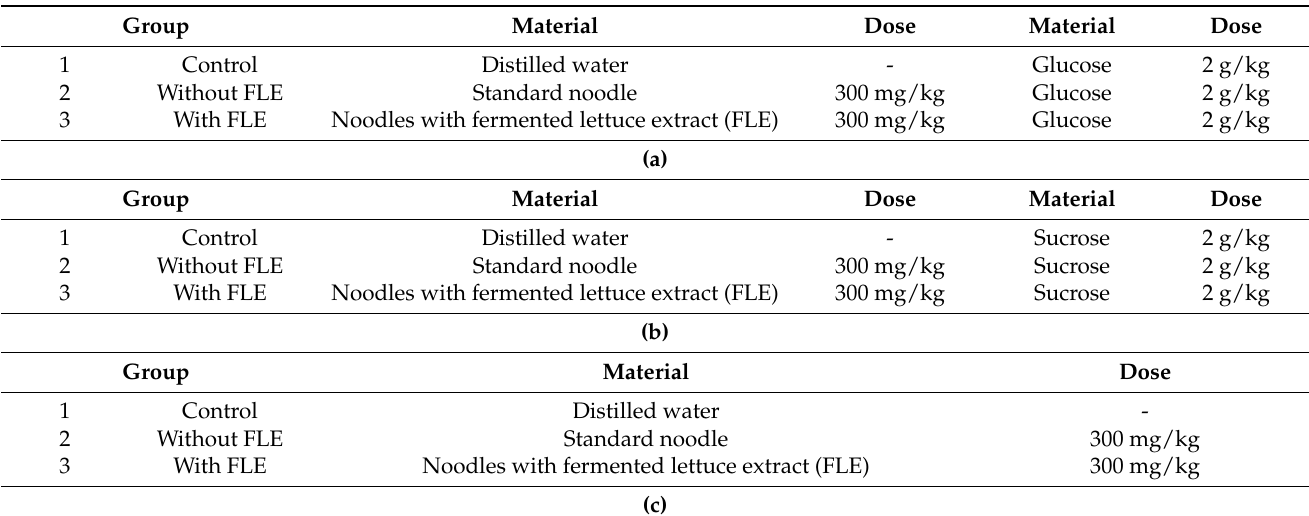
Table 4. Experimental design to study oral ( a ) glucose and ( b ) sucrose tolerance tests, and ( c ) fasting glucose test of the noodles in a diabetic mice